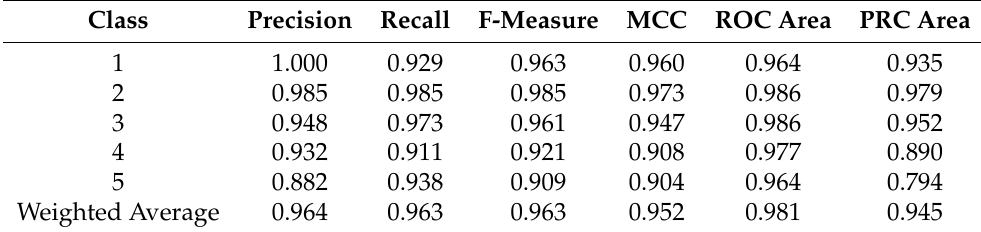
Table 22. J48 accuracy details.